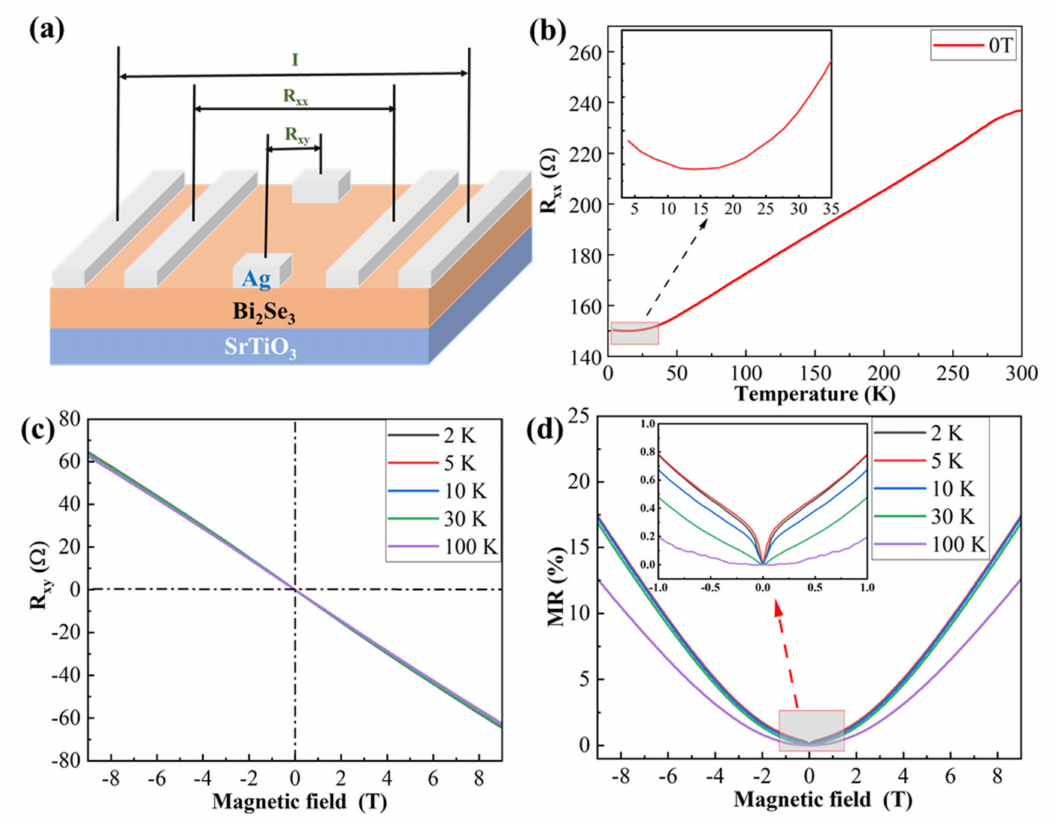
Figure 3. Electrical transport measurement of Bi 2 Se 3 thin film. ( a ) Schematic diagram of sample and electrodes. ( b ) R xx curves as a function of temperature under magnetic fields of 0 T and 9 T (the inset is an enlarged view at <35 K); ( c ) Hall resistance curves as a function of magnetic field at different temperatures; ( d ) magnetoresistance curve of the sample as a function of magnetic field (the inset is an enlarged view of the low magnetic field − 1~1